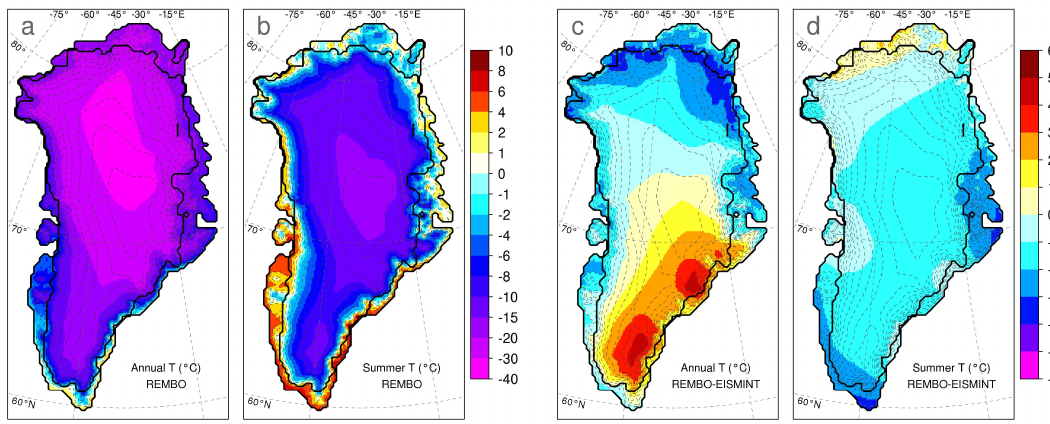
Fig. 3. REMBO model output of (a) mean annual temperature and (b) mean summer (JJA) temperature. Difference between REMBO and EISMINT for (c) mean annual temperature and (d) mean summer (JJA) temperature. Elevation contours are shown at 300m intervals.